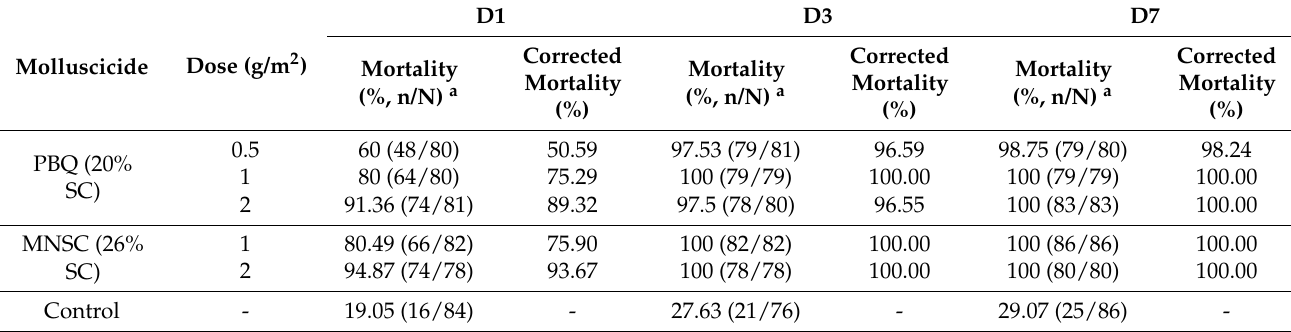
Table 3. Molluscicidal effect of PBQ (20% SC) in field